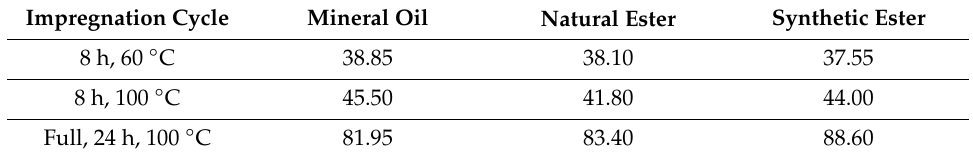
Table 7. Median of breakdown voltages of pressboard impregnated in a different ways (kV). Impregnation Cycle